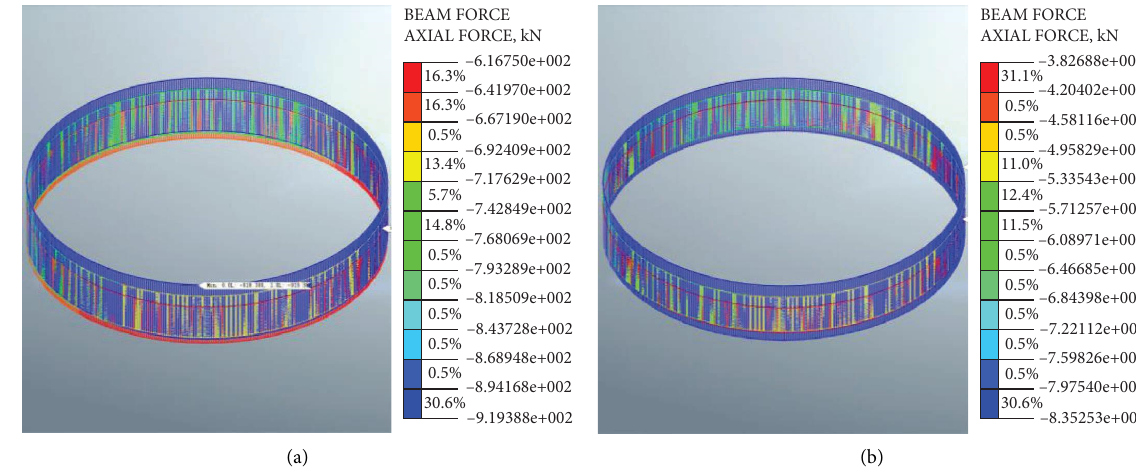
Figure 31: Working condition 4 lining axial force (a) without pore water pressure and (b) with pore water pressure applied.